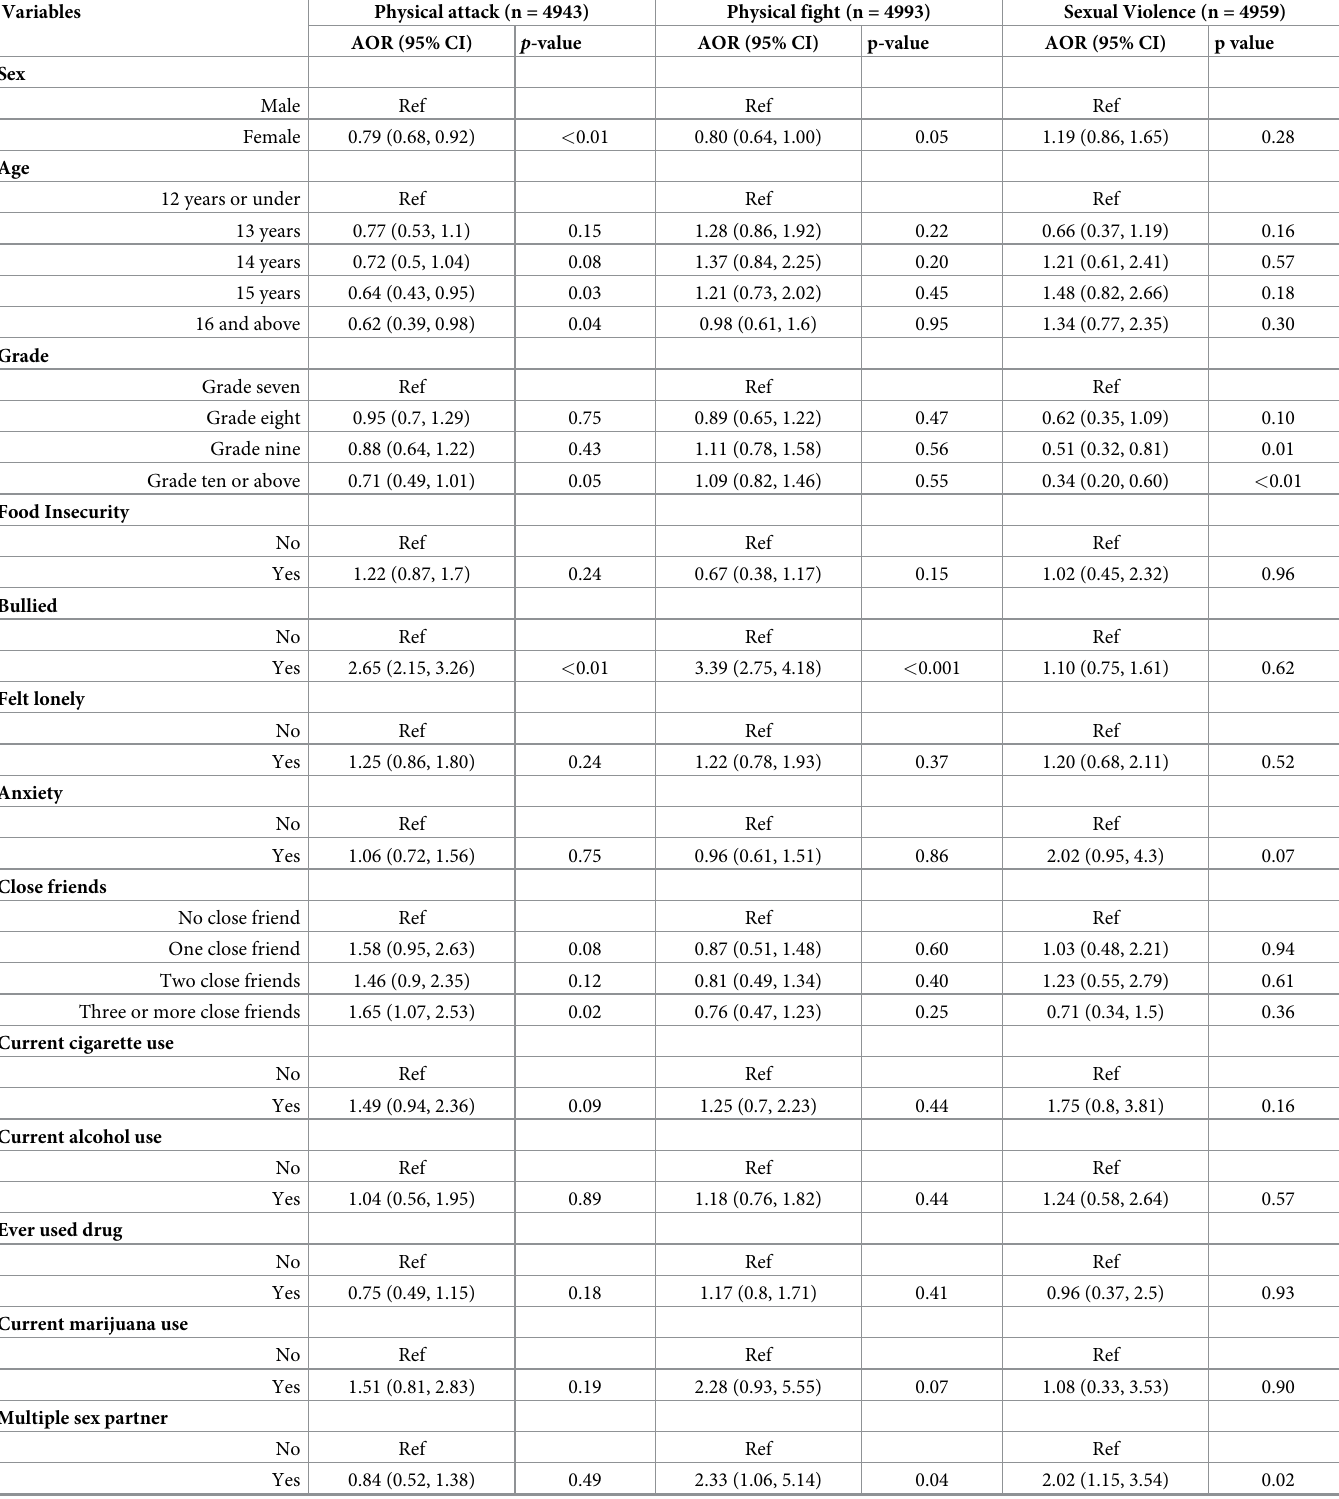
Table 4. Factors associated with physical attack, physical fight, and sexual violence in multivariate analysis.